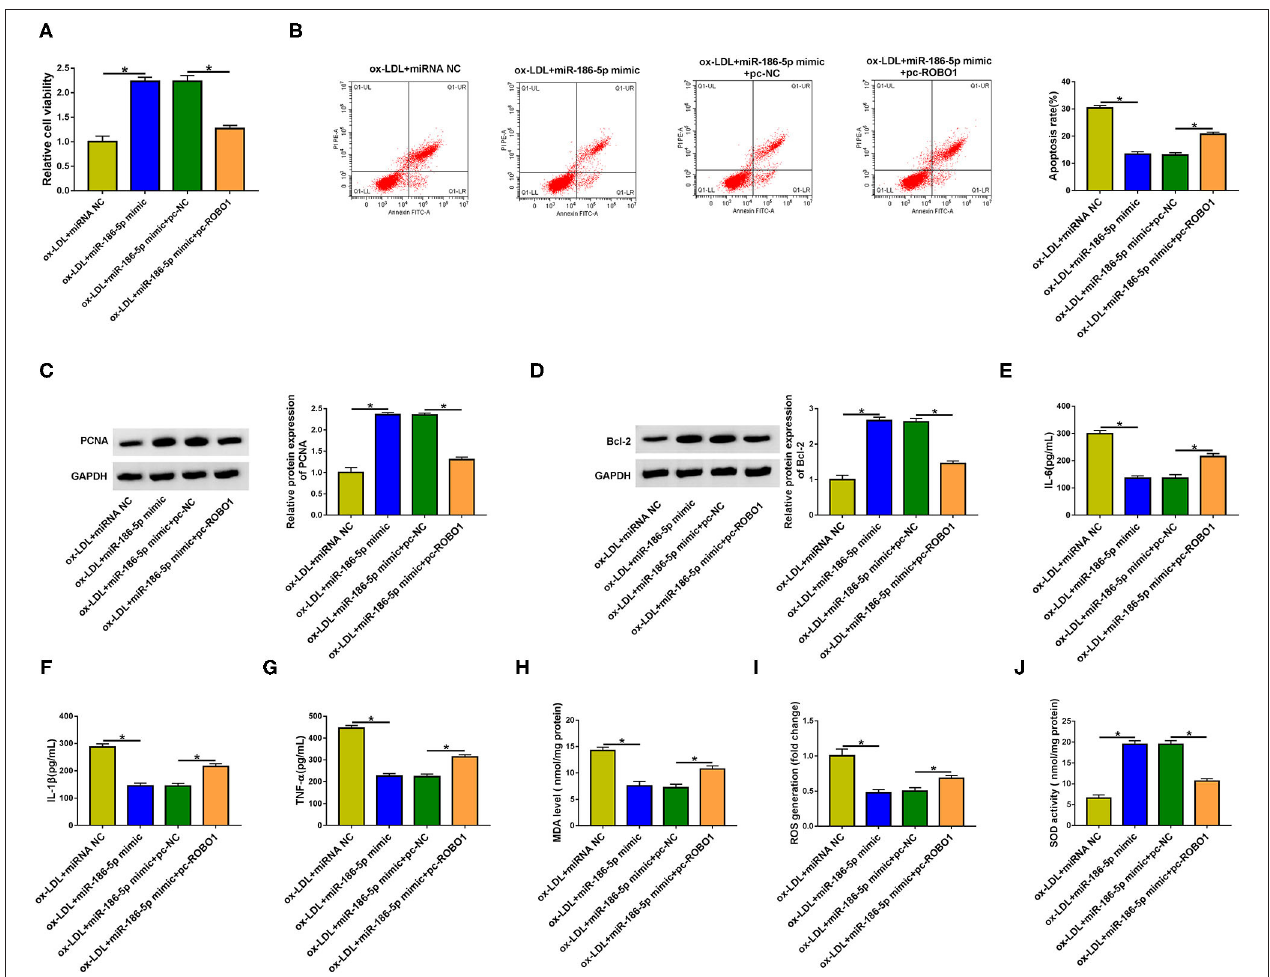
FIGURE 6 | ROBO1 overexpression largely overturns miR-186-5p-mediated effects in HUVECs upon ox-LDL exposure. (A–J) HUVECs transfected with miR-186-5p mimic alone or together with pc-ROBO1 were stimulated with ox-LDL (40 mg/L, 24h). One-way ANOVA followed by Tukey’s post hoc test was used to assess the differences. (A) Cell viability was assessed by MTT assay. This experiment was performed three times with five technical repetitions each time. (B) The apoptosis rate was measured by flow cytometry. This experiment was performed three times with three technical repetitions each time. (C) The level of PCNA protein was measured by Western blot assay. This experiment was performed three times. (D) Western blot assay was utilized to detect the protein level of Bcl-2 in HUVECs. This experiment was performed three times. (E–G) The levels of IL-6, IL-1 β , and TNF- α were determined by ELISA. This experiment was performed three times with three technical repetitions each time. (H–J) Cell oxidative stress was analyzed by corresponding kits. This experiment was performed three times with three technical repetitions each time. * P < 0.05.